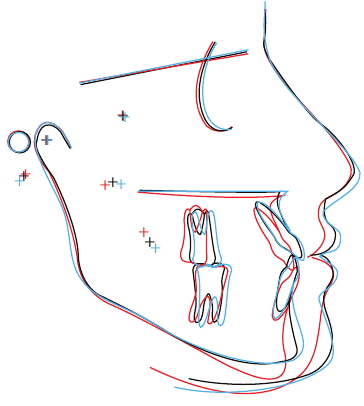
Figure 11: Pretreatment, postsurgical, and 7-year posttreatment cephalometric superimposition